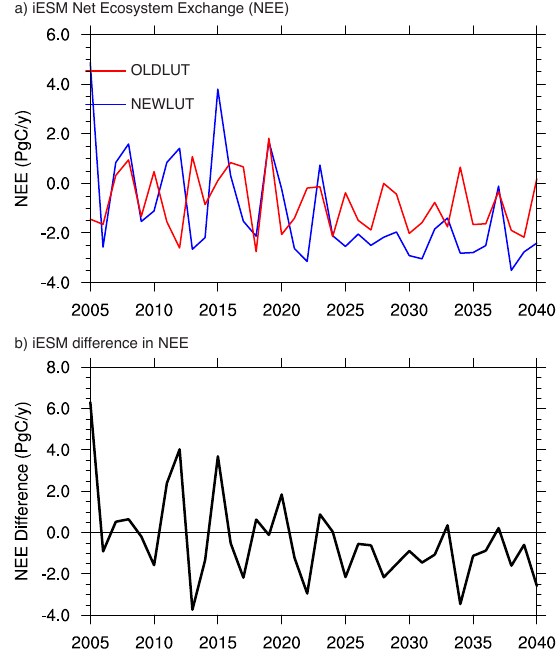
Figure 9. Net ecosystem exchange (NEE) comparison between iESM simulations. (a) NEE for each simulation. (b) NEE differ- ence (NEWLUT minus OLDLUT). These data show more land car- bon uptake (negative NEE), associated with the additional trees, for the NEWLUT simulation during the afforestation period (2015 for-